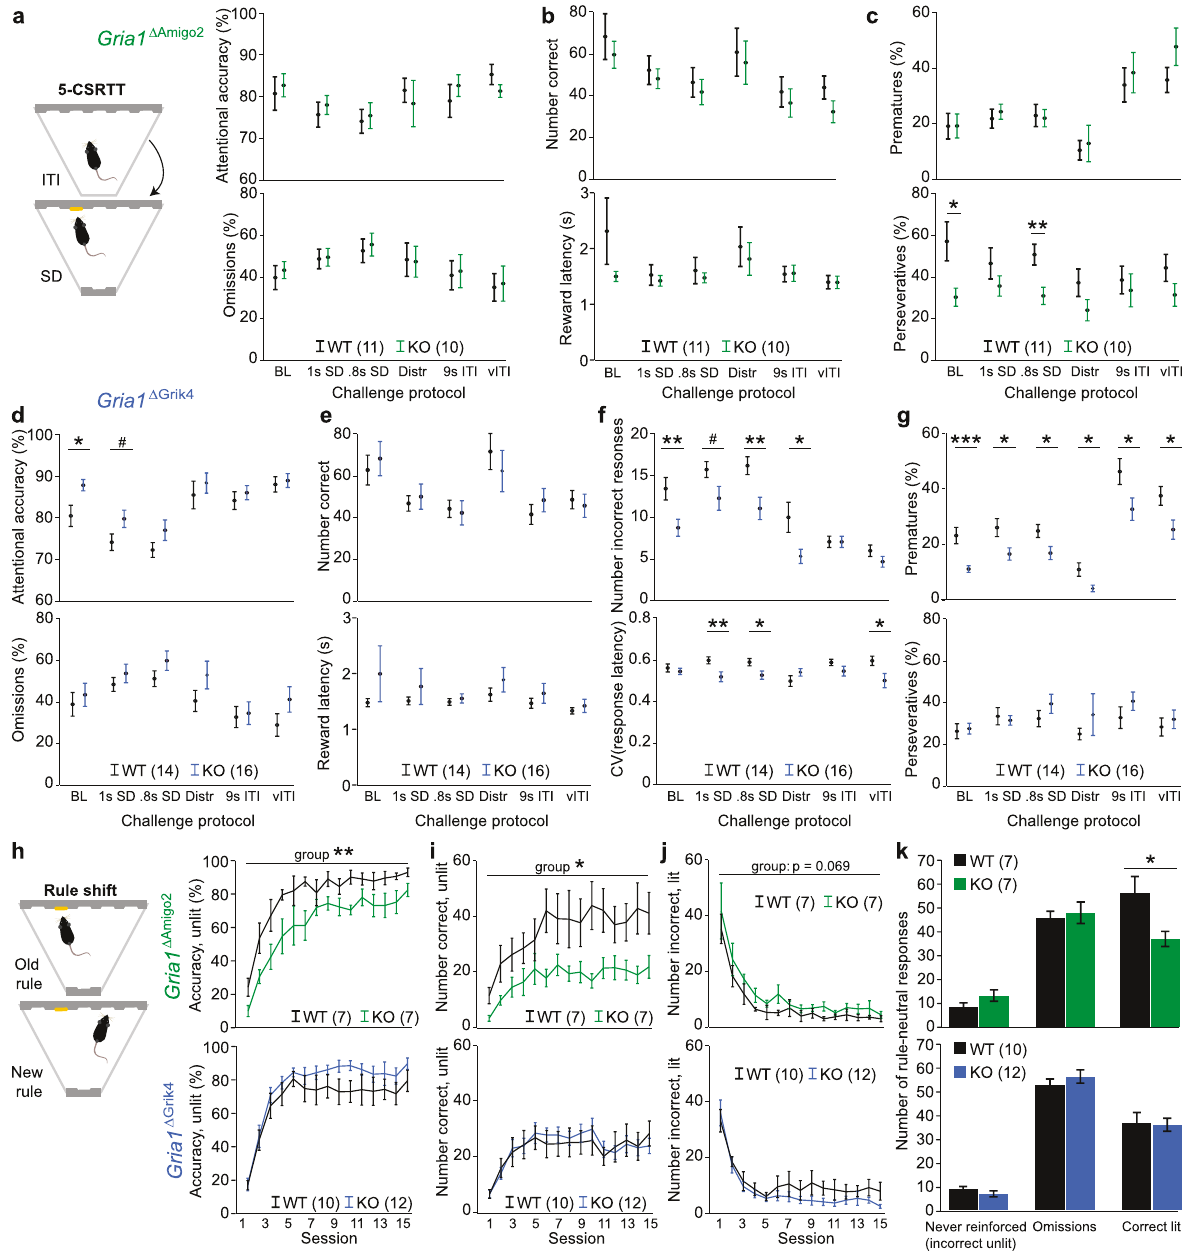
Fig. 5 Ablation of GluA1 from CA2/CA3 affects sustained attention, impulse control and cognitive fl exibility. a – g Illustration ( a , left) and key performance parameter of the 5-CSRTT in Gria1 Δ Amigo2 ( a – c ) and Gria1 Δ Grik4 mice ( d – g ); including indicators of sustained attention (accuracy) and task engagement (%omissions; a , d ), motivational drive (number correct responses, reward latency; b , e ), impulsivity (% prematures) and perseveration (%perseverative responses; c , g ). Given the increase of attentional accuracy in Gria1 Δ Grik4 mice, additional attentional parameters are shown for this cohort ( f ): the number of incorrect responses and the variability of response latency (coef fi cient of variation, CV). In all cases, performance is shown for the baseline protocol (BL) and fi ve additional challenge protocols challenging either mainly attention (reduction of stimulus duration, SD, to 1 s or 0.8 s, or auditory distraction, Distr) or mainly impulse control ( fi xed 9 s or variable extension of the intertrial interval, ITI, waiting time) as indicated on x axes. h – j Key parameters of learning progress in the rule-shift assay in cohorts indicated in ( h ) as extracted from those 50% of trials in each session in which the old and the new rule are in con fl ict because the correct hole is not illuminated while the incorrect one is; including accuracy of choice for correct non-illuminated hole (the number of correct choices divided by the number of correct and incorrect (lit) choices; h ), the total number of correct responses into the unlit hole ( i ), and of incorrect pokes into lit hole ( j ). k Average number of those responses that are not affected by the rule shift across the fi rst 15 sessions. N - numbers are stated in the colour legends of each panel. Cohorts are mixed sex in both cases and animals that have not reached criteria on or before the baseline stages of each task were excluded from testing. The two cohorts were treated separately for statistical comparison between wild-type and control data. RM-ANOVA was used for analysing data over time ( h – j ), univariate ANOVAs for the remainder. See Supplementary Tables 3 and 4 for the statistical results. All graphs show mean ± s.e.m. *** P < 0.001, ** P < 0.01, * P < 0.05, # P <